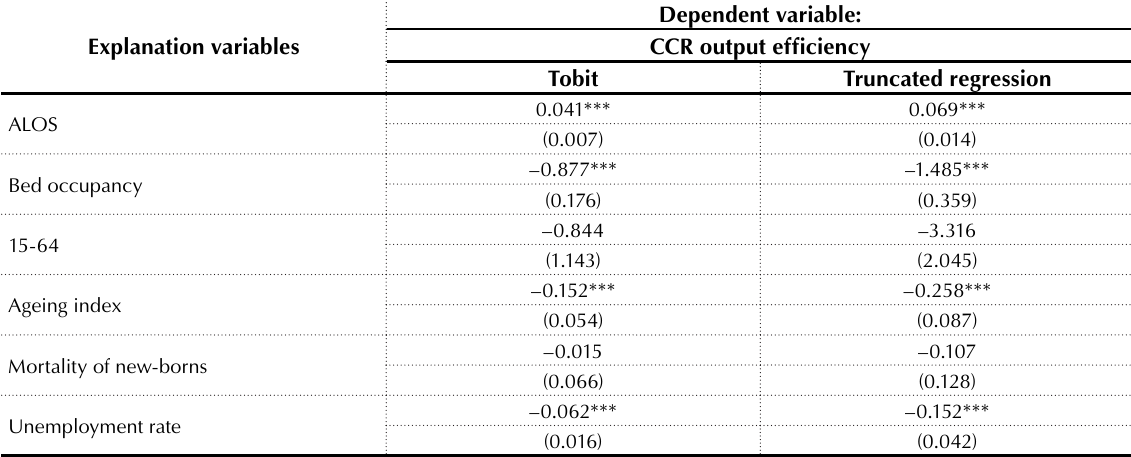
Table 5. Regression models results